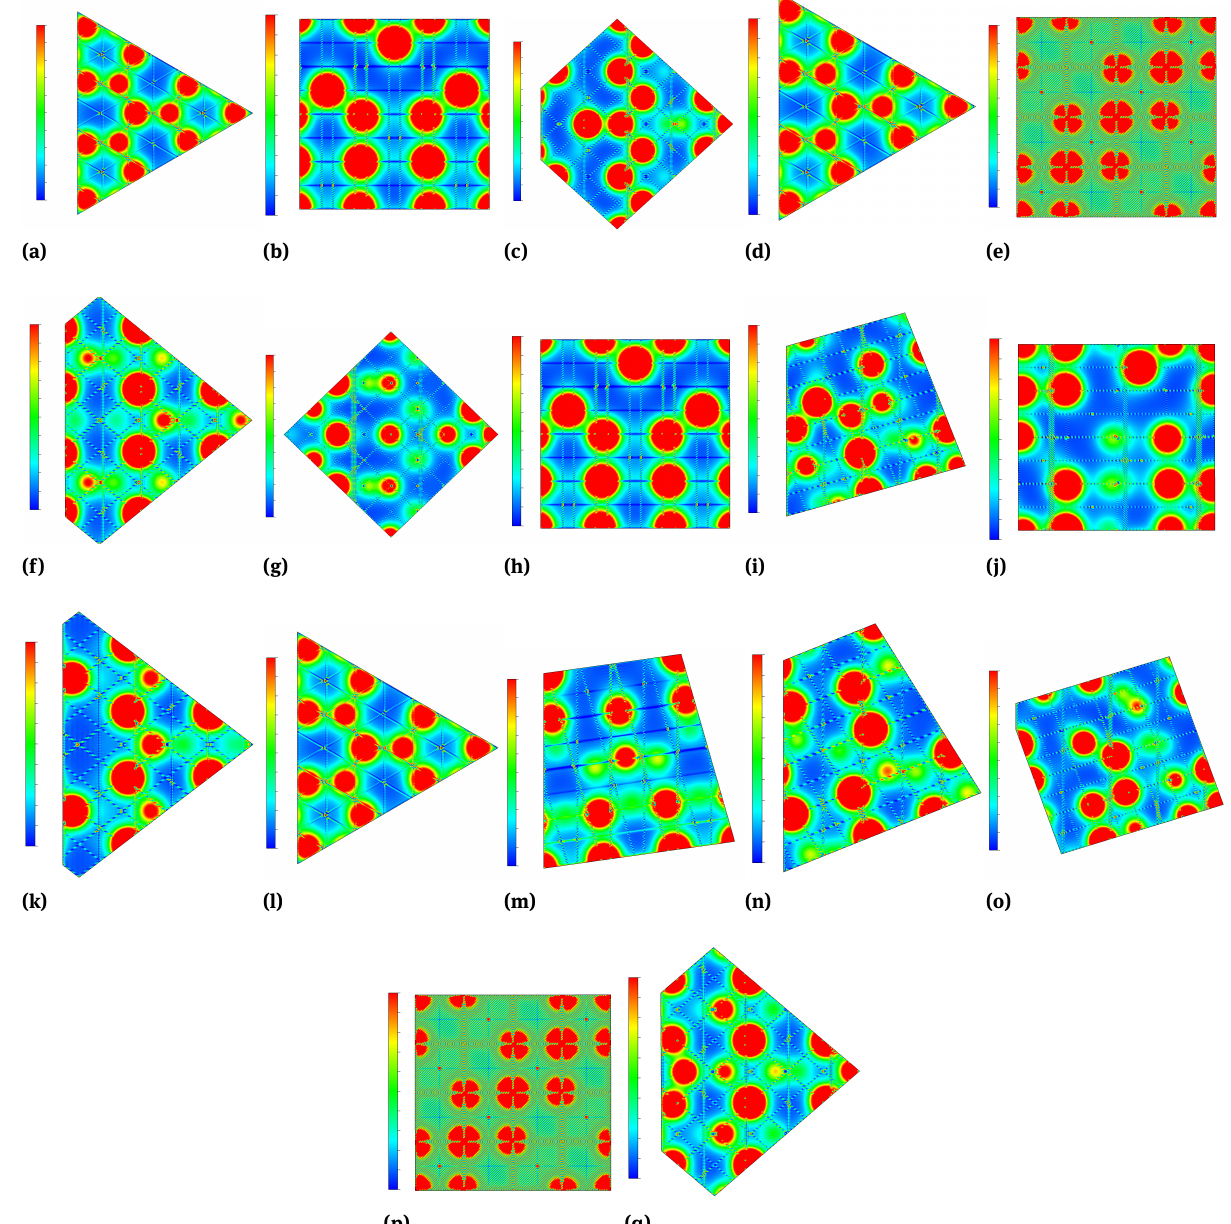
Figure 5: Electron density of different planes for Co x Cu 1-x Fe 2 O 4 peaks (a):111 plane; (b): 022 plane; (c): 113 plane; (d):222 plane; (e):004 plane; (f): 224 plane; (g): 115 plane; (h):044 plane; (i):135 plane; (j): 026 plane; (k): 335 plane; (l):444 plane; (m): 155 plane; (n):246 plane; (o): 137 plane; (p):008 plane; (q):337